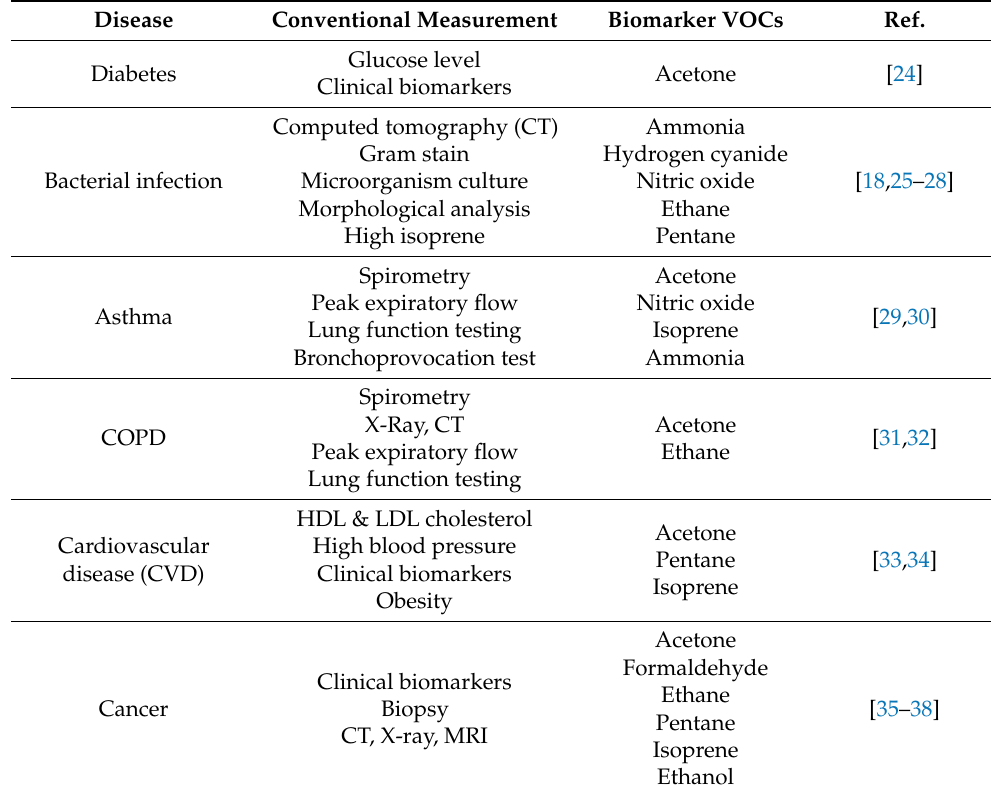
Table 1. Conventional measurements with the candidate group for biomarker volatile organic com- pounds (VOCs) in exhaled breath gas by a diagnosable disease. A simple and efficient e-nose platform that can distinguish VOCs in exhaled gas can be used as a selective self-diagnostic